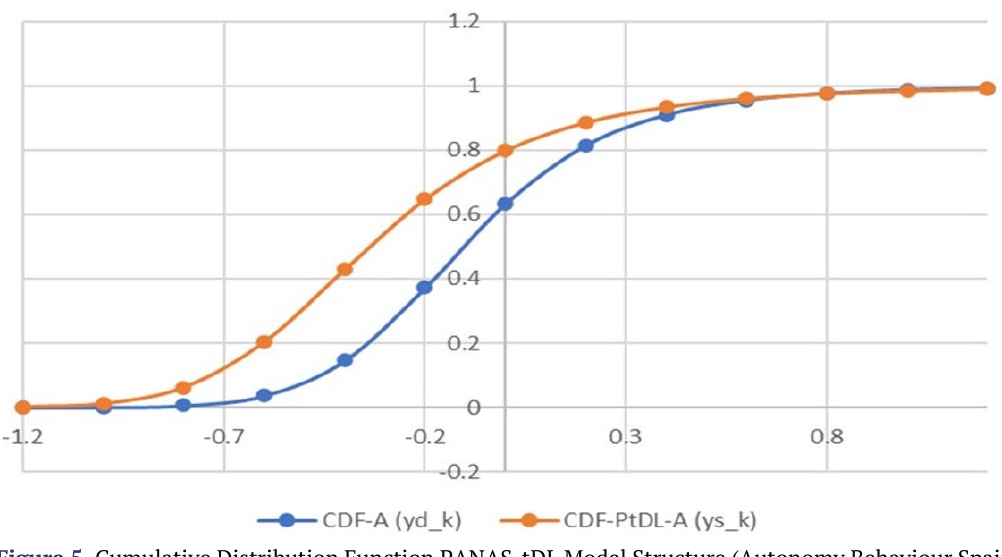
Figure 5. Cumulative Distribution Function PANAS-tDL Model Structure (Autonomy Behaviour Spain)